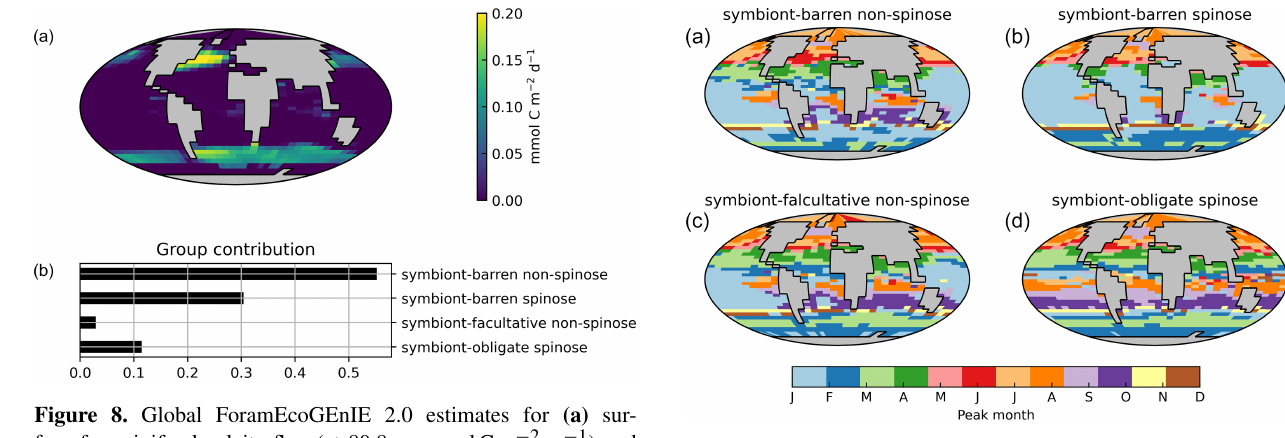
Figure 9. The peak month of modelled biomass annual time series of each foraminiferal group in our best ForamEcoGEnIE 2.0 run. Note that the months in Southern Hemisphere indicate the opposite seasonality of the Northern